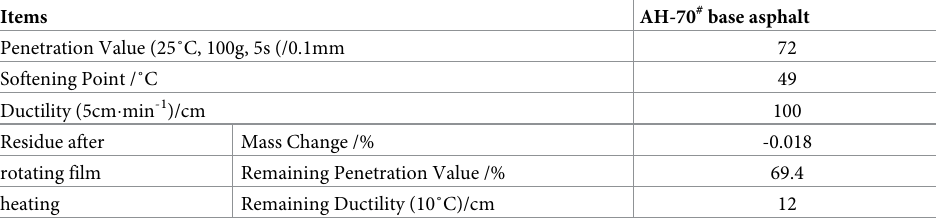
Table 1. The main technical performance of AH-70# asphalt.